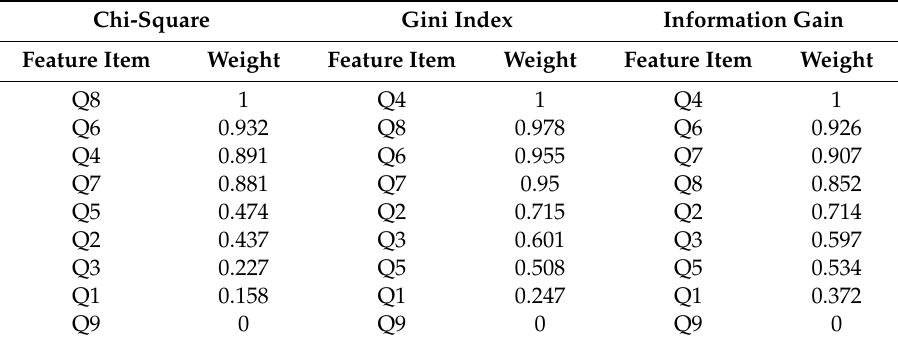
Table 4. Feature selection using chi-Square, Gini index, and information gain.